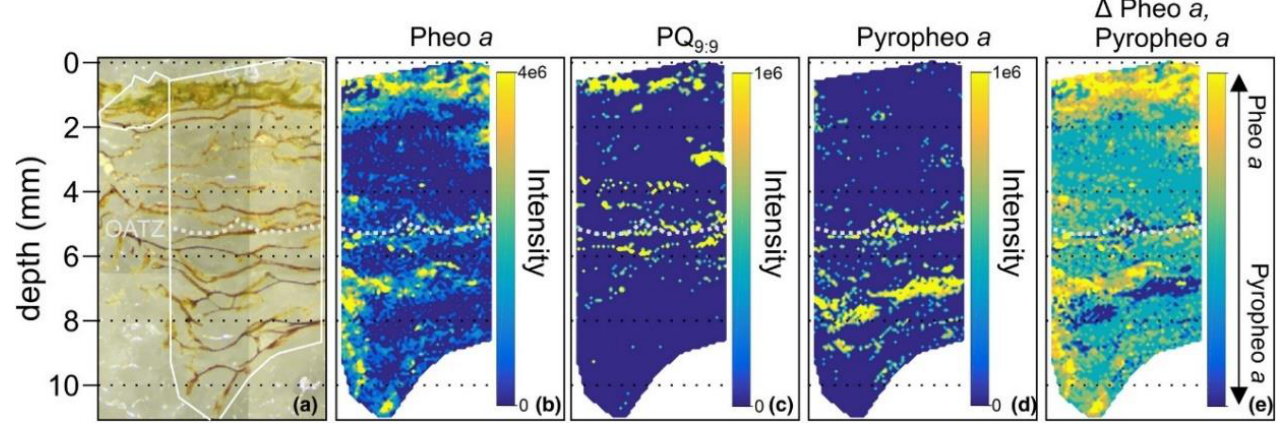
Figure 4. Images of the mat slice ( a ) and 75 µm resolution MSI of pheophytin (Pheo) a , plastoquinone (PQ9:9) and pyropheophytin a ( b – d ) depicting the spatial distribution of the oxygenic chlorophoto- troph Synechococcus spp. Panel ( e ) shows the difference between the normalized relative abundance of Pheo a and Pyropheophytin a (denoted as Δ Pheo a , Pyropheo a ). Figure and caption were repro- duced with permission from Wörmer and colleagues [96].